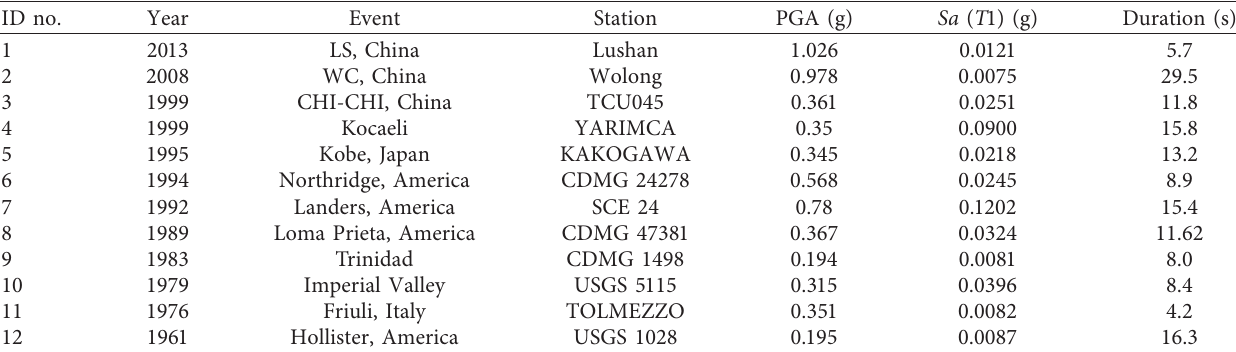
Figure 4: The dimensional model of the Puli Bridge in SAP2000. (a) First-order vibration mode. (b) Second-order vibration mode. (c) Third-order vibration mode. (d) Fourth-order vibration mode. Table 2: Characteristics of the earthquake ground motion histories.